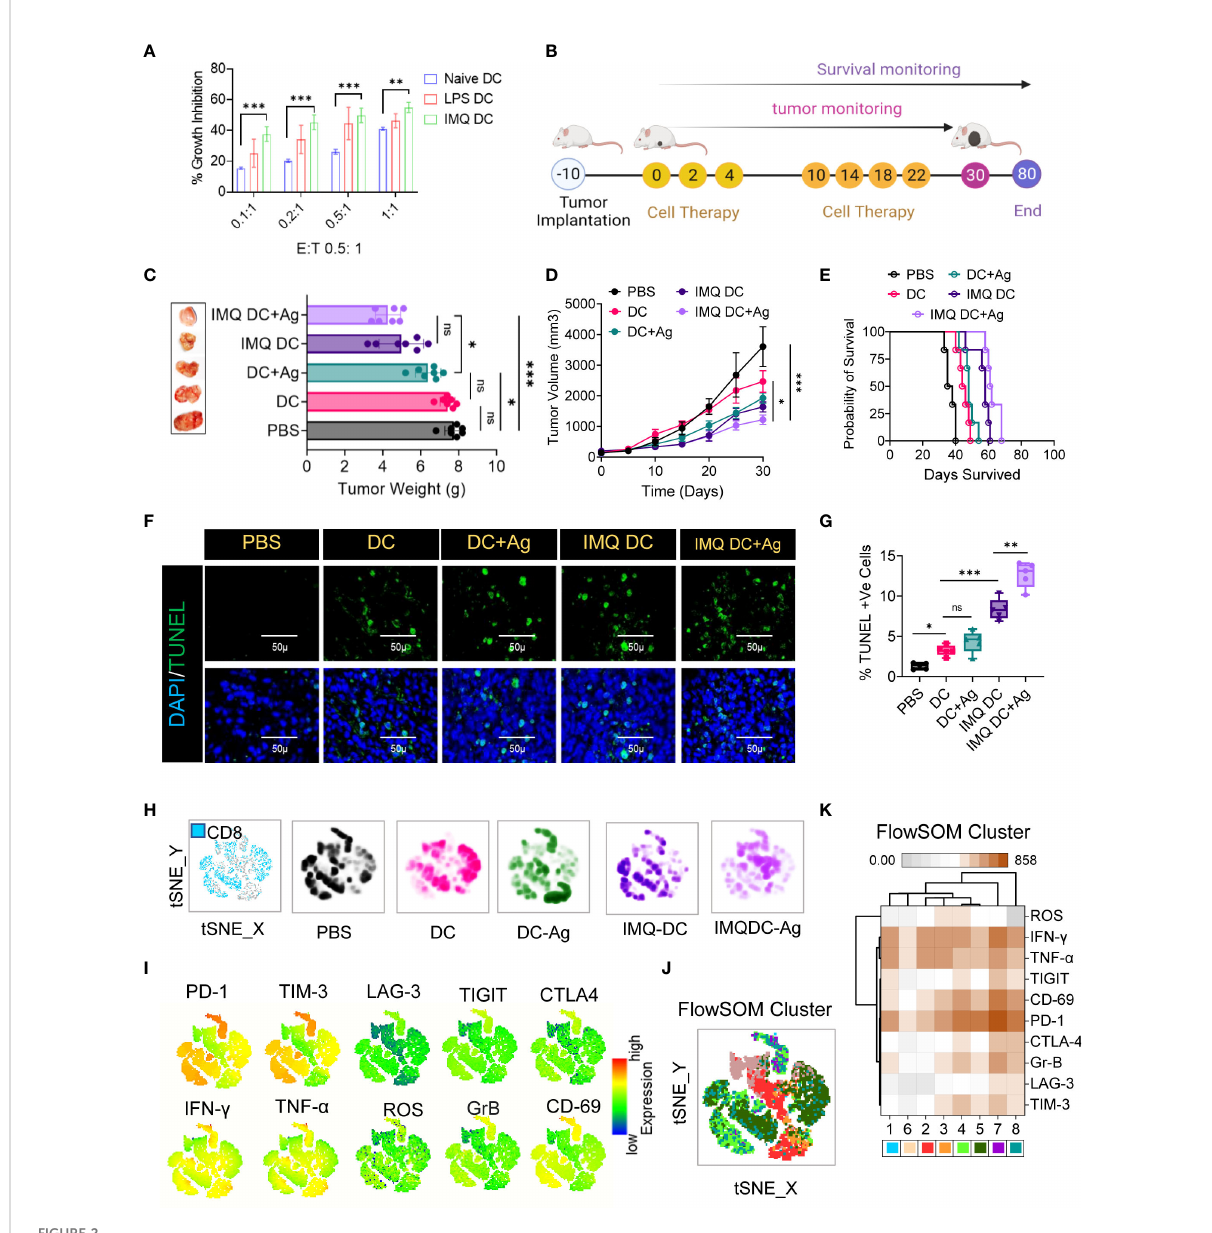
FIGURE 2 Robust exhausted T-cell populations in CRC mice restrain DC immunotherapy ef fi cacy. (A) In vitro tumoricidal activity of naïve and imiquimod (200 pg/mL)-activated DCs was assessed by MTT assay. LPS (10 m g/ml) was used as a positive control. Treatment of CRC tumors: (B) Experimental schedule; after 10 days of s.c. inoculation with 5 × 10 4 CT-26 cells when tumors reached approximately 90 mm 3 , the treatment was initiated (noted as Day 0) with PBS, DCs, IMQ-activated DCs or DCs pulsed with whole tumor antigen every 2 days for a total of 6 times. (C) The tumor weight (mean ± SD, n=6) of each indicated group and representative images of the tumors dissected on the indicated days. (D) Tumor growth curves (n=6). (E) Kaplan – Meier analysis of the mice; n = 6 mice. (F) TUNEL staining of the tumor sections dissected on day 30; green: TUNEL; blue: DAPI; scale bars: 50 m m; the experiment was repeated independently three times to con fi rm the results. (G) Boxes represent interquartile ranges (IQRs) of the percentage of TUNEL-positive cells. The experiment was performed in triplicate with four mice, and the results are presented as the mean±SD. (H) Global tSNE projection of nonnaïve CD8 + T cells for all pooled (blue) and indicated treatment groups. (I) tSNE maps showing the expression level and the distribution of each indicated marker. The color scale indicates the relative expression levels. (J) tSNE projection of CD8 + T-cell clusters (colored differently) identi fi ed by FlowSOM clustering. (K) Mean fl uorescence intensity (MFI) as indicated (column-scaled z scores) markers for selected clusters. The color scale indicates the relative expression levels. Statistical signi fi cance was analyzed by two-tailed Student ’ s t test (C, D) or by the log-rank (Mantel – Cox) test (E) . Unless otherwise noted, the data are presented as independent biological triplicates. In vivo studies were repeated independently fi ve times to con fi rm the results. ns, not signi fi cant, *p < 0.05, **p < 0.01, and ***p <